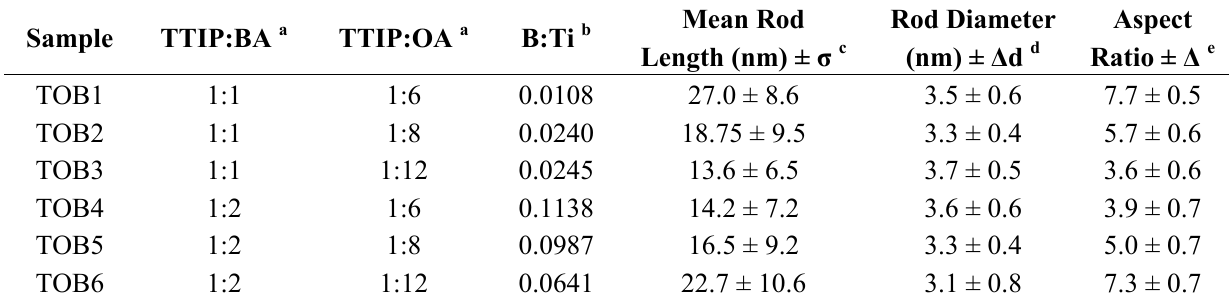
Table 1. Effective boron amount, nominal molar ratios of TTIP, boric acid (BA) and oleic acid (OA) and TEM image analysis.